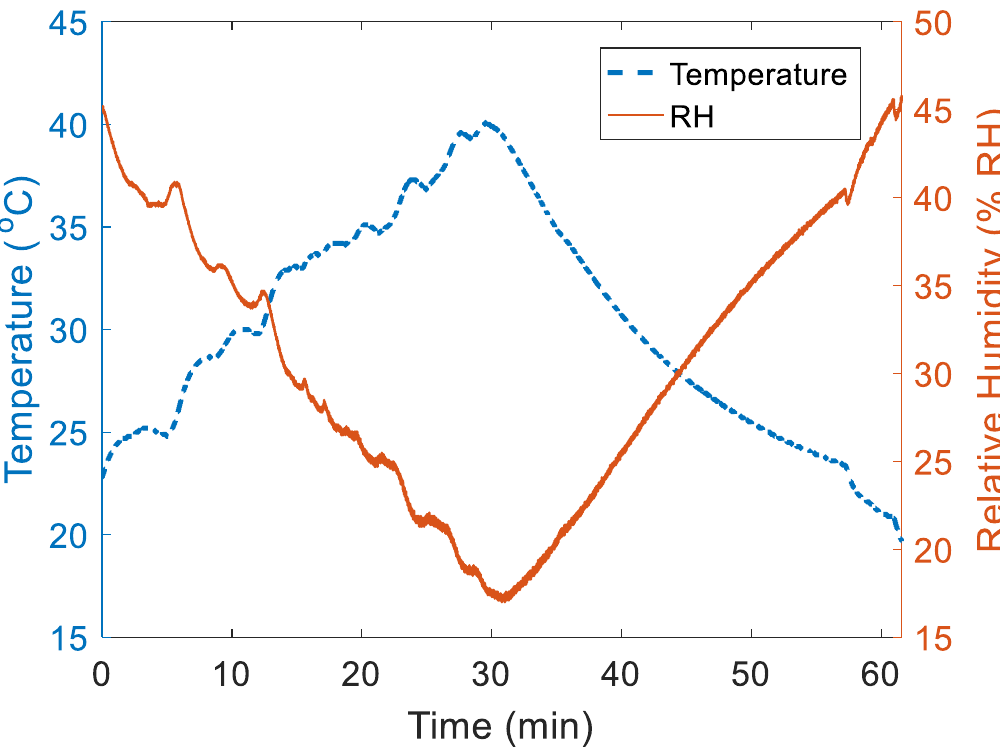
Figure 4. Graphical representation of the one-hour heating trial to illustrate the relationship between temperature change and relative humidity (RH) inside the relatively sealed environment created within the slot in the foam cushion. The dashed line represents the variation in temperature values (created by changing water temperature inside a metal container, which was monitored by reading from an Hg thermometer) and the solid line is the response of RH within the enclosed space in the foam cushion slot (environmental condition: 43.0% ± 1.4% RH and 22.5 °C ± 0.2 °C).